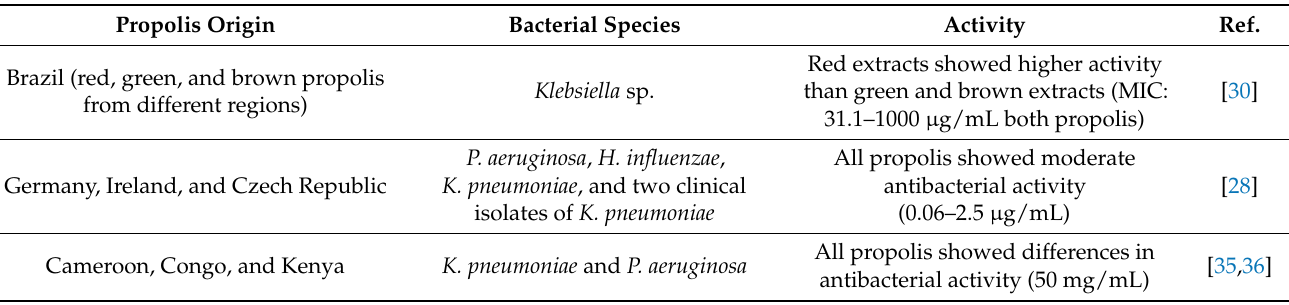
Table 6. Antibacterial activity of diverse propolis on different microorganisms that cause nosocomial infections. Propolis Origin